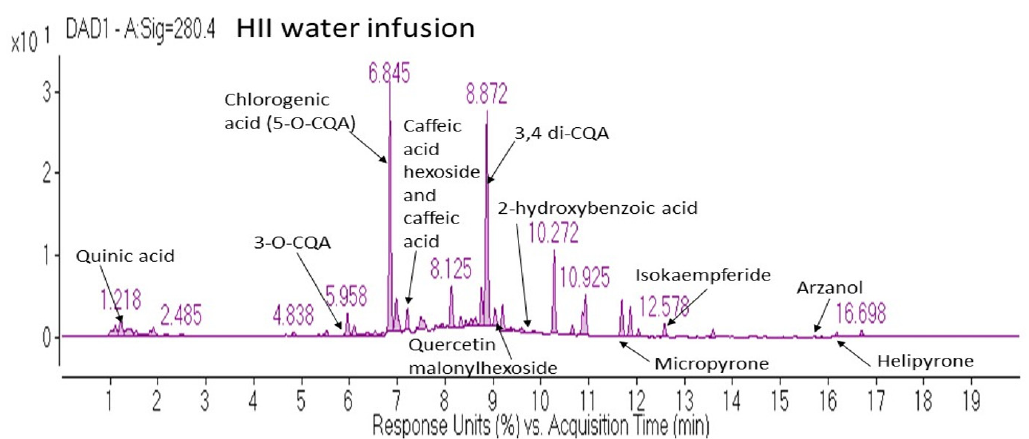
Figure 1. Representative diode array detector chromatogram at 280 nm of H. italicum ssp. italicum water infusion with peak annotations of the most characteristic compounds detected in the infusion. CQA—Caffeoyl quinic acid, DAD—diode array detector, HII— Helichrysum italicum ssp. italicum